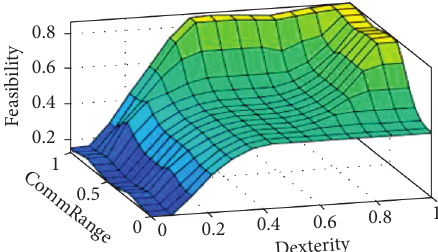
Figure 28: Fuzzy output surface for model r .